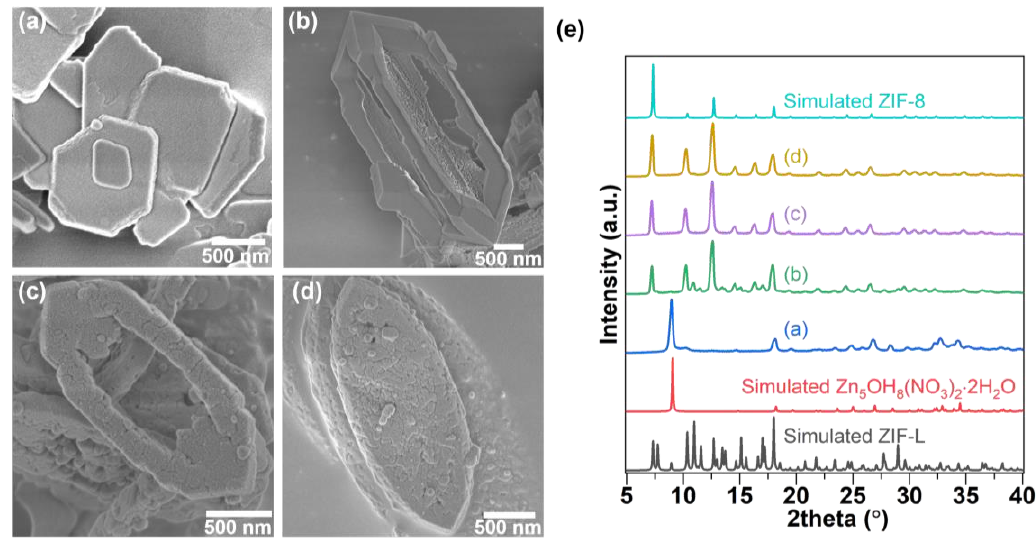
Figure 3. SEM images of ZIF-L after 8 h of exposure with ( a ) 1 M Zn 2+ , ( b ) 0.1 M 2mIm, ( c ) 0.01 M CTAB, and ( d ) 0.05 M CTAB containing DMAc/H 2 O solution at 333 K, ( e ) XRD pattern of crystals as illustrated in ( a – d ).